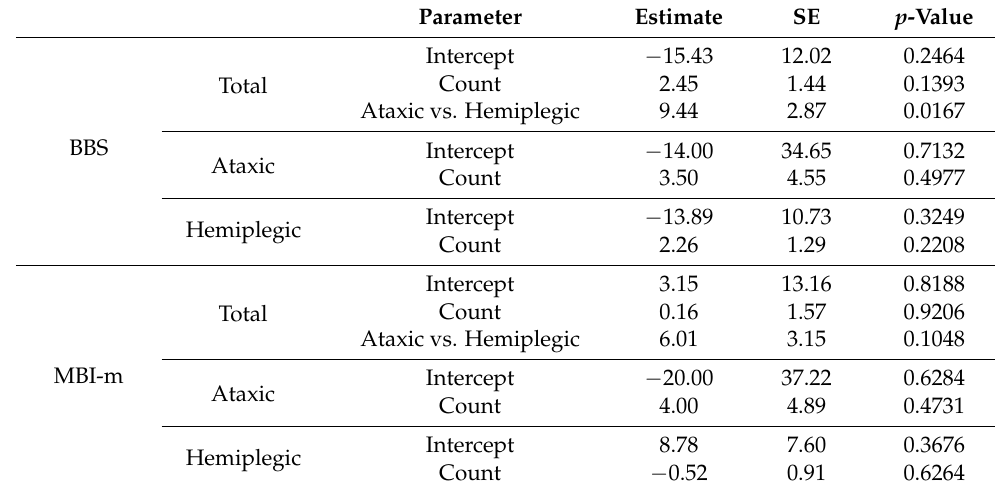
Table 4. Linear regression analysis of the effect of the number of RAGT sessions on BBS and MBI-m.